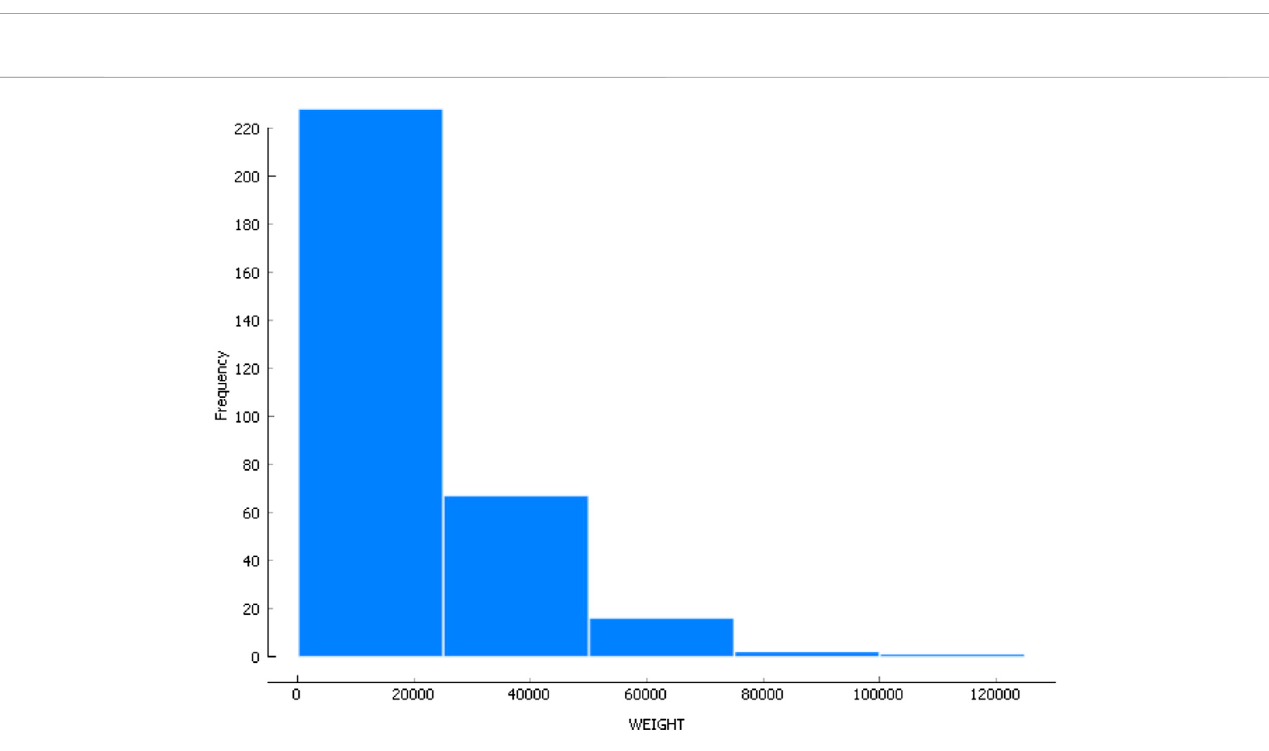
FIGURE 7 Frequency of range of waste weight